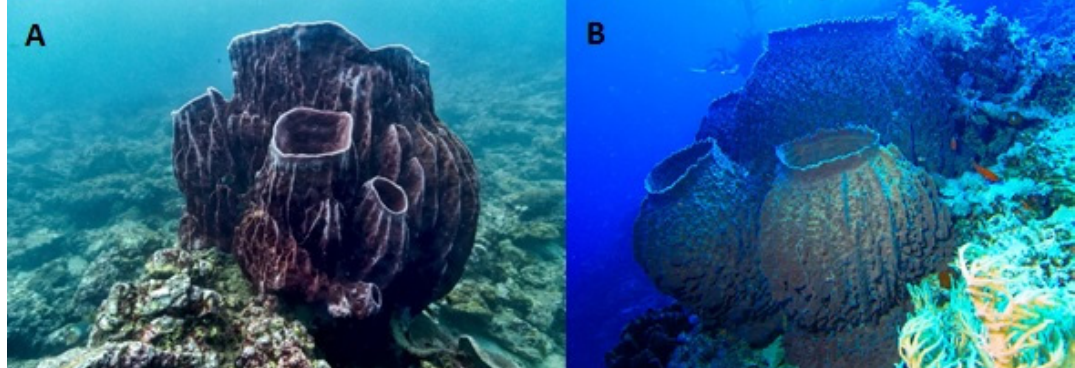
Figure 7. Examples of specimens of Xestospongia sp. ( A ) X. muta © Renaud Houdinet; https: // flickr.com / ; ( B ) X. testudinaria , photo by Albert Kok (Public domain) https: // commons.wikimedia.org / .